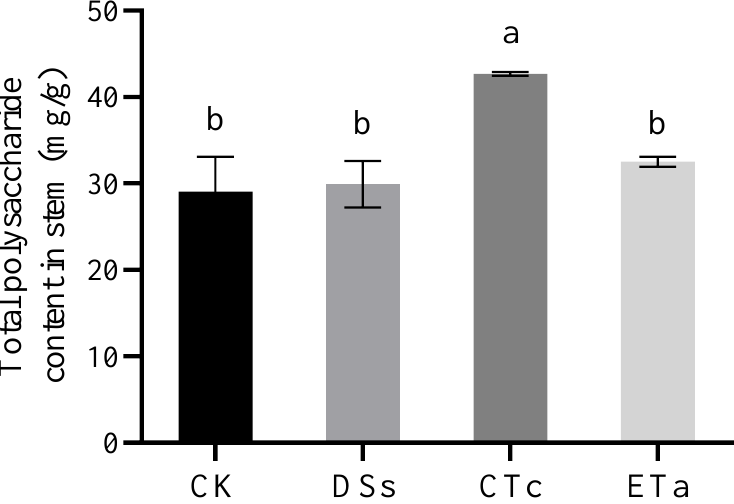
Figure 6. Relationship between relative conductivity and leaves of CK, DSs, CTc and ETa groups. Different lowercase letters are significantly different ( p < 0.05) based on Tukey tests.